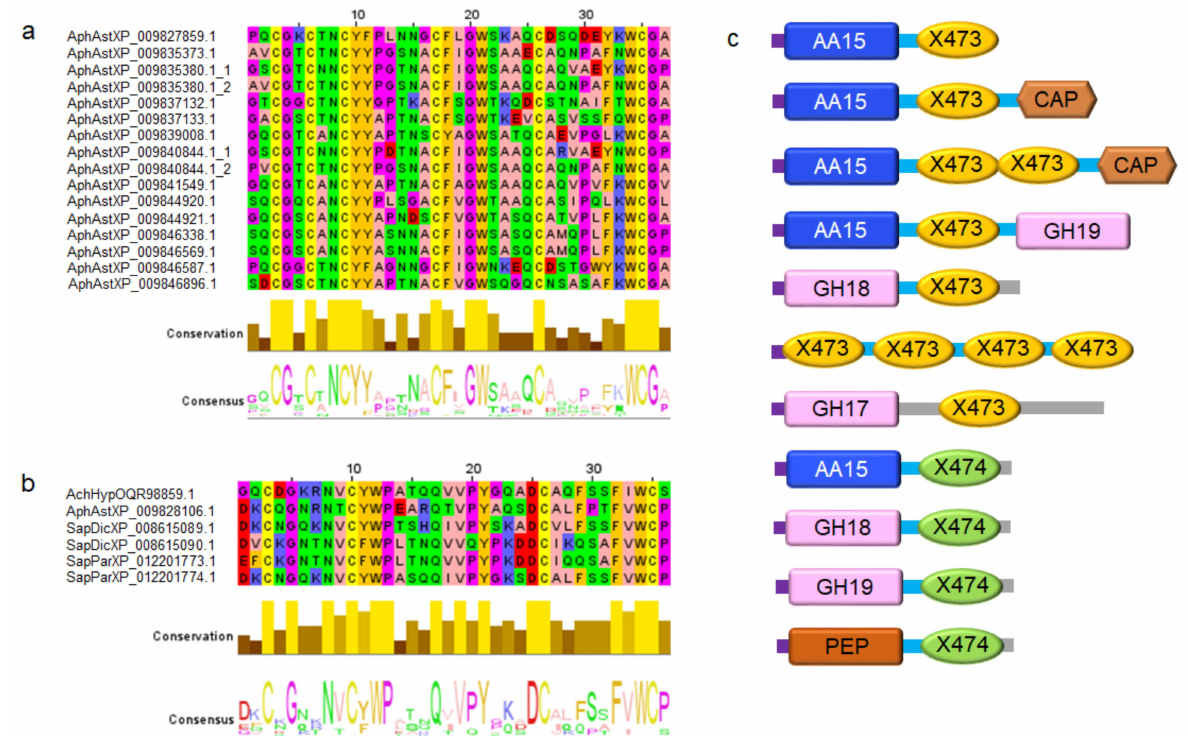
Figure 3. Multiple sequence alignment and architecture of X473 and X474 domains. ( a ) Alignment of X473 sequences found to be fused to AA15 LPMOs in A. astaci . ( b ) Alignment of X474 sequences found to be fused to AA15 LPMOs from A. astaci , A. hypogyna , S. diclina and S. parasitica . The alignments show absolute conservation of the cysteine residues (six and four in X473 and X474, respectively) putatively involved in disulfide bond formation. The bottom part of panels a and b also shows the level of conservation and the consensus sequence. Sequences are labelled with the species name (AphAst = A. astaci , AchHyp = A. hypogyna , SapDic = S. diclina , SapPar = S. parasitica ) followed by the NCBI reference number. ( c ) Domain architecture of proteins carrying the X473 and X474 extensions in Saprolegniales . Both X473 and X474 are normally associated with chitinases (GH18, GH19). X474 is occasionally fused to putative M14 metallocarboxypeptidases, C1 cysteine peptidases, and trypsin-like serine proteases (“PEP”). Purple: predicted signal peptide. Light blue: putative linker peptide. Grey: unknown. CBM1: carbohydrate binding module 1 (cellulose-specific). GH17: glycoside hydrolase family 17. GH18: glycoside hydrolase family 18. GH19: glycoside hydrolase family 19. X473 and X474: newly identified domains, putatively involved in binding chitin. CAP = cysteine-rich secretory proteins, antigen 5, and pathogenesis-related 1 proteins superfamily